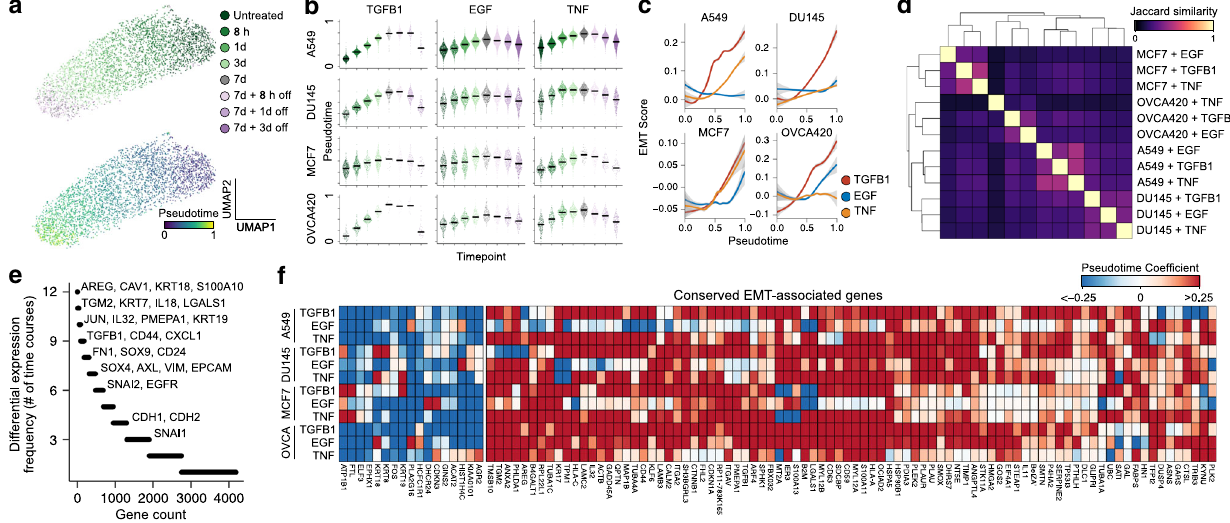
Fig. 2 EMT transcriptional responses are largely context speci fi c. a UMAP embeddings of A549 cells treated with TGFB1. Each point represents an individual cell, and colors correspond to time point (top) or pseudotime value (bottom). b Sina plot showing the distribution of pseudotime values across time points for all 12 time course experiments, with time points colored the same as in a . Horizontal black bars represent mean expression values for each group and each point corresponds to a single cell. c Smoothed model of the EMT hallmark gene set score throughout the pseudotime. Shaded bands for each line correspond to the standard error for each model. d Clustered heatmap of all pairwise Jaccard similarity values for the differentially expressed genes in each condition. e Counts of how frequently each gene is differentially expressed among time course experiments. f Heatmap showing EMT- associated expression changes associated with a gene set of all genes that are differentially expressed in at least eight time course experiments. The colormap corresponds to the pseudotime beta coef fi cient of the linear model for each